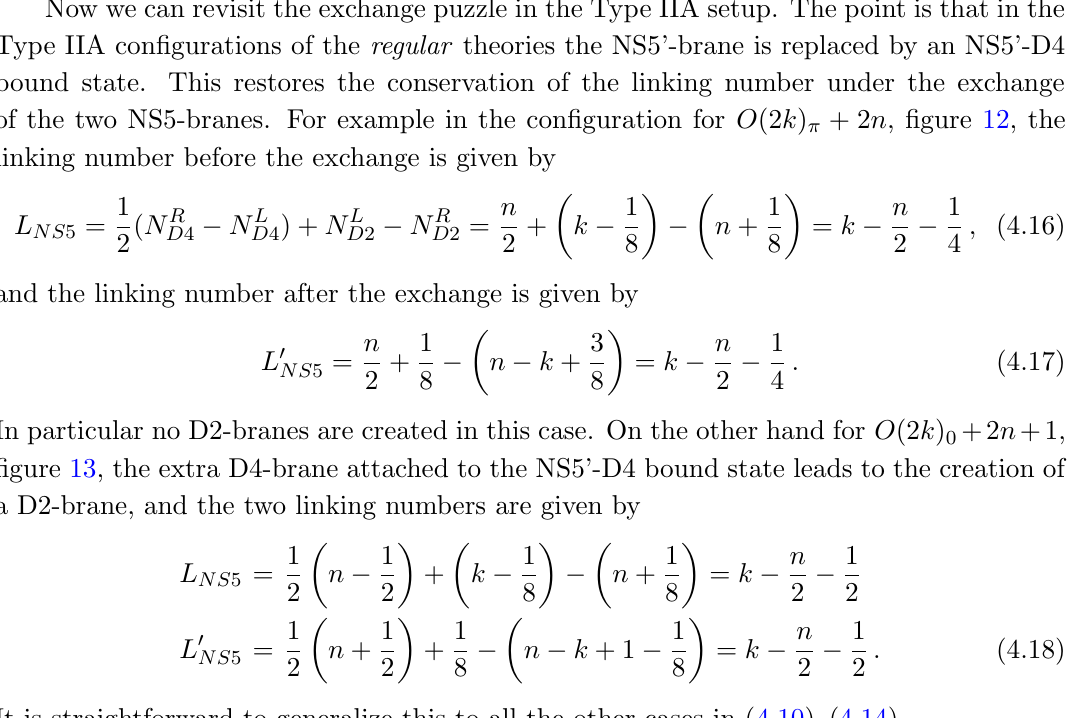
Figure 12 . Duality move in the Type IIA brane con(cid:12)guration for O (2 k ) to an NS5-D4 bound state. In other words the reduction of a single M5-brane to Type